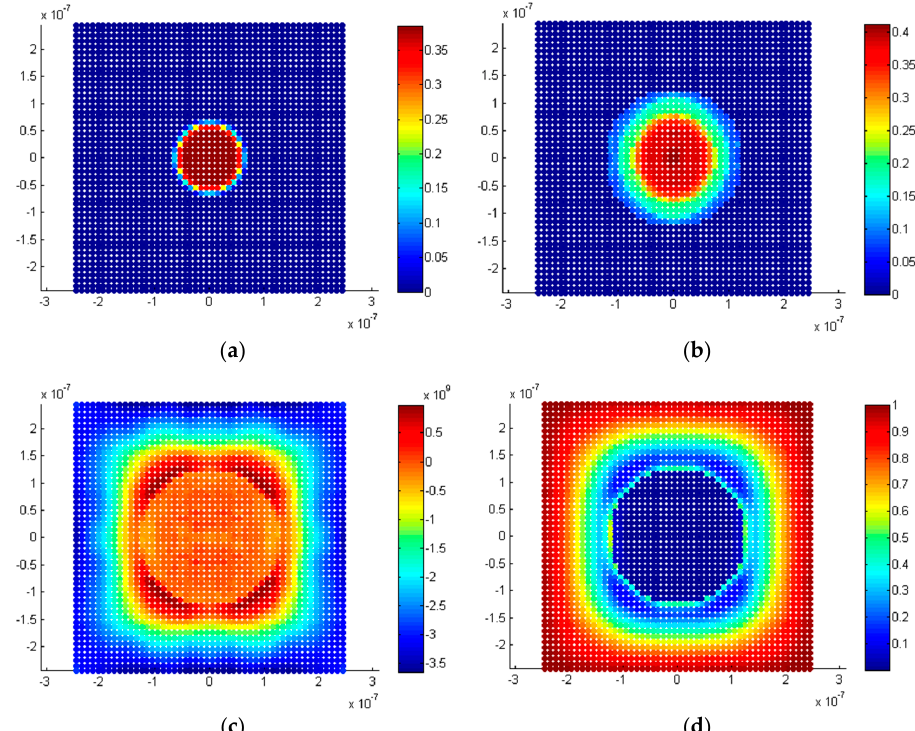
Figure 10. Result plots of cylindrical anode with a single vertical crack in the y - z mid-plane: ( a ) initial damage; ( b ) damage after deformation; ( c ) hydrostatic stress; and ( d ) lithium ion concentration.